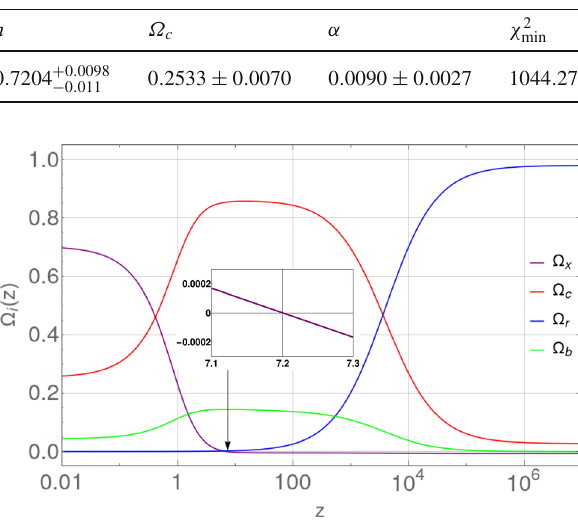
Table 9 Best fit parameters and 1 σ error for the observational analysis of the Γ 1 T scenario